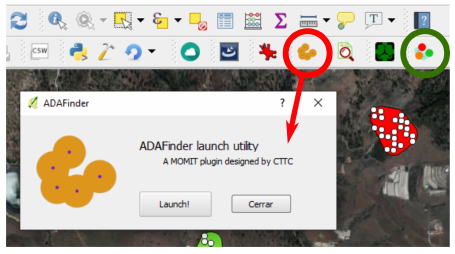
Figure 2. Integrating the tools in Quantum